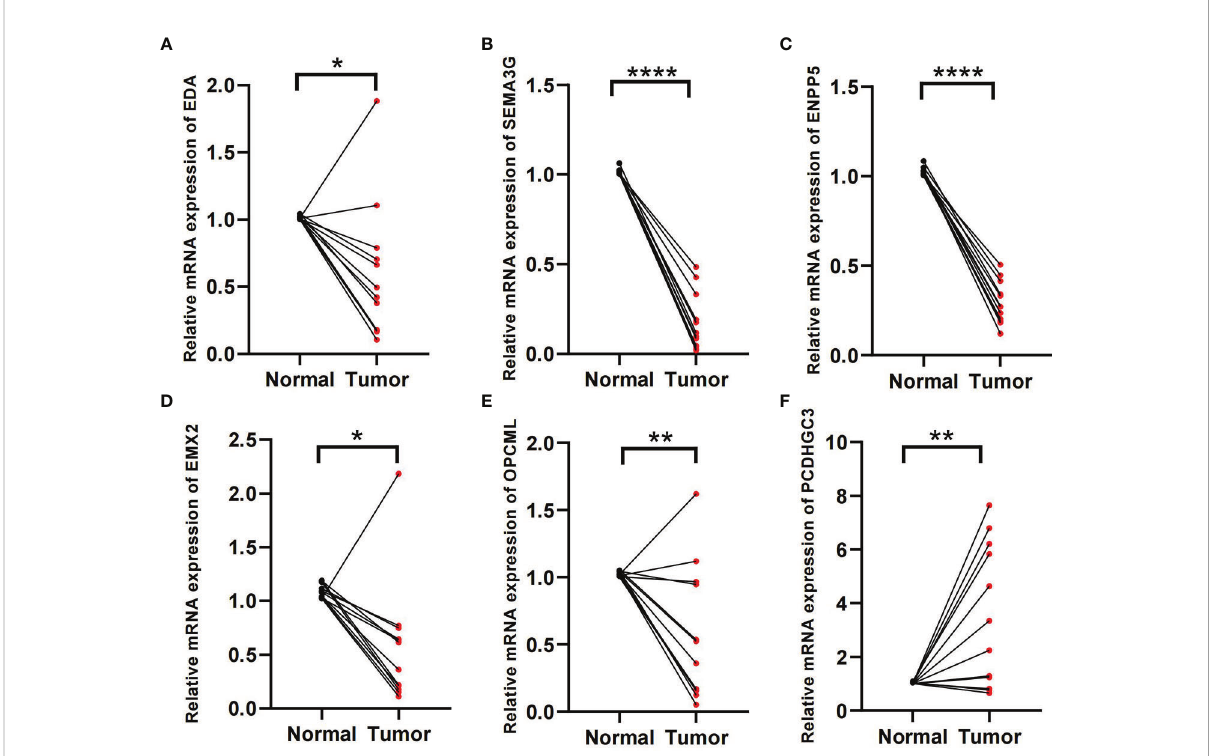
FIGURE 8 Validation of tissue samples. (A – F) Expression of EDA, SEMA3G, ENPP5, EMX2, OPCM, and PCDHGC3 in ccRCC cancer and normal tissues. *p < 0.05, **p < 0.01, ****p <